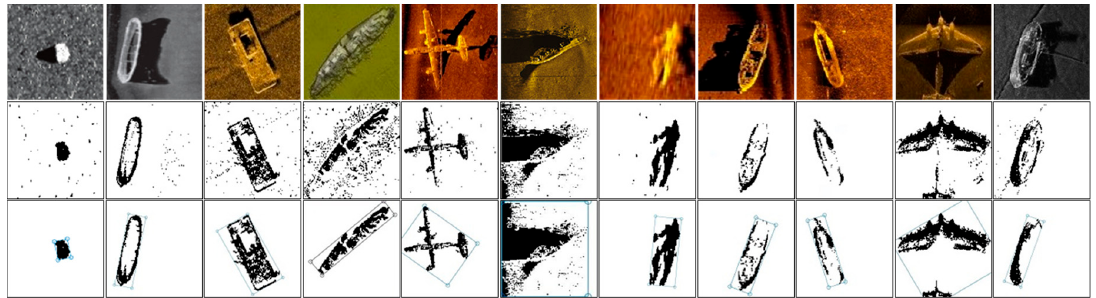
Figure 8. Initial evolution contour generation experiment. The first row: Original sonar images. The second row: Image clustering analysis. The third row: The initial evolution contours obtained after removing the spurious points.